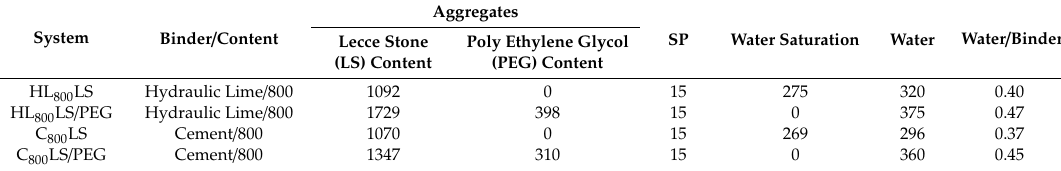
Table 1. Mortar compositions (reported as kg / m 3 of produced